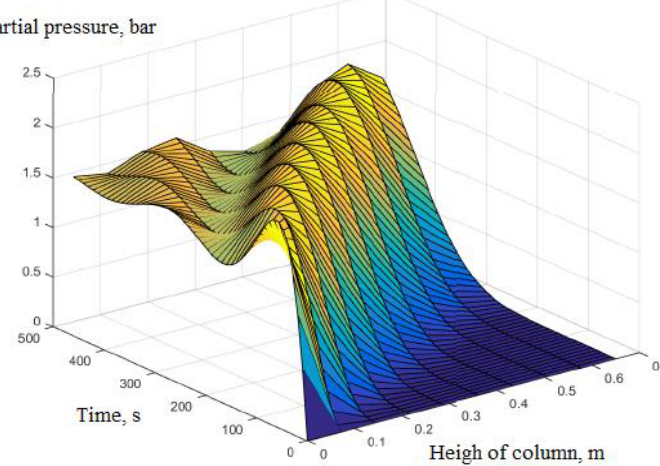
Figure 10. The result of partial pressure (O 2 ) following over time and height of column at 8 bar.